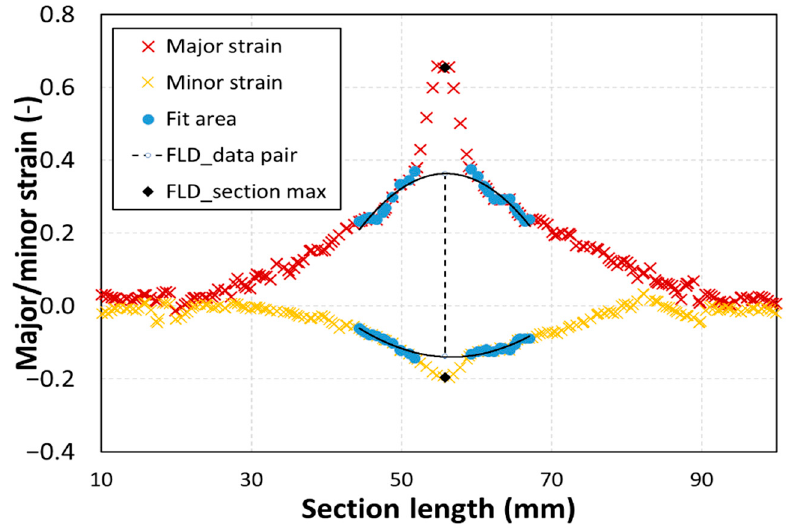
Figure 1. Determination of the forming limit diagram (FLD) values, cross-section method and section maximum method.